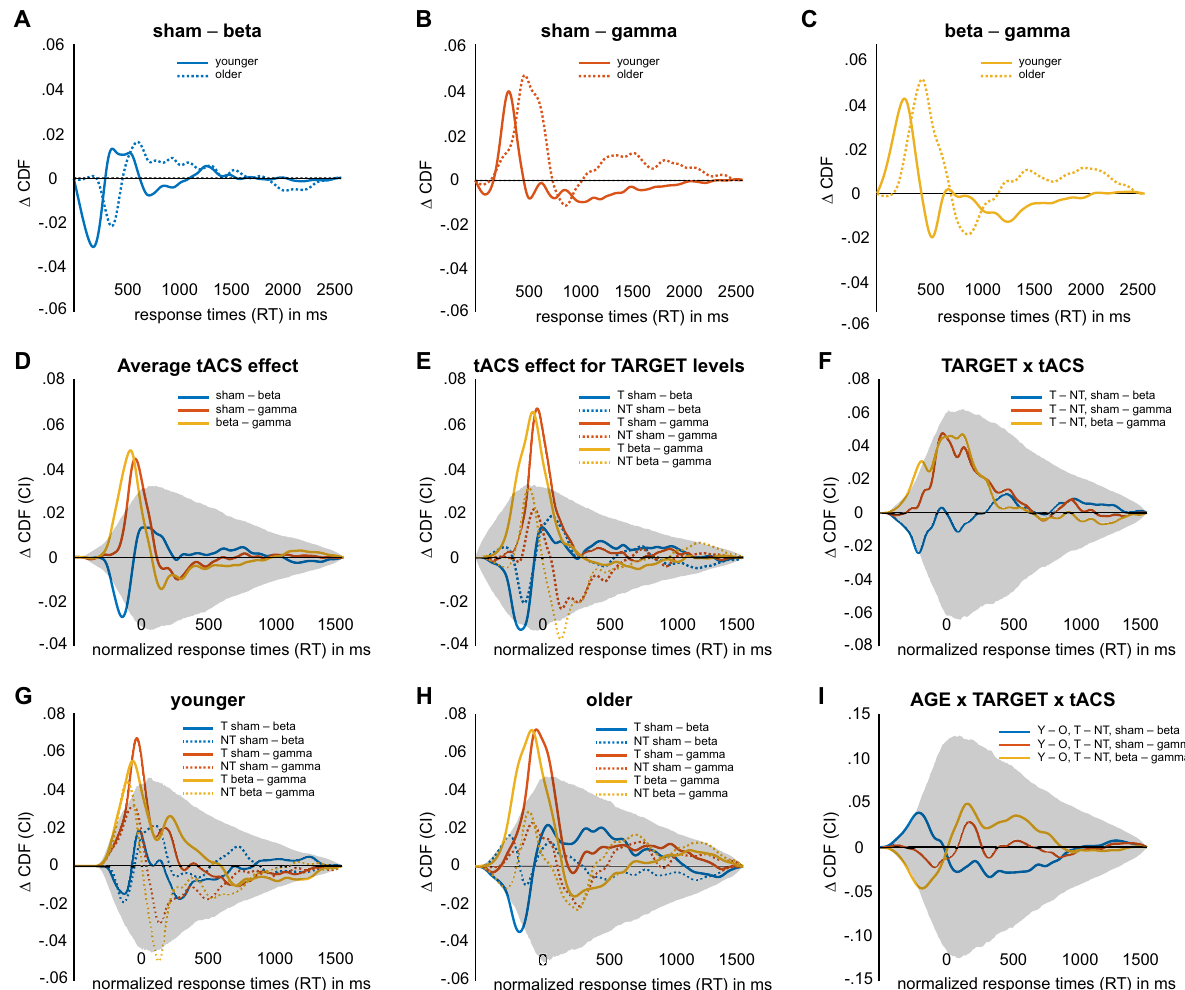
Figure 5. tACS-related differences between cumulative distribution functions (CDFs) of response times (RTs). Grey shaded areas depict confidence intervals corrected for multiple testing. ( A ) Effect of beta tACS (20 Hz) on uncorrected CDFs shown separately for age groups (same data with confidence intervals is depicted in Supplementary Fig. 1). ( B ) Effect of gamma tACS (70 Hz) on uncorrected CDFs shown separately for age groups. ( C ) Difference between beta and gamma tACS on uncorrected CDFs shown separately for age groups. ( D ) Average tACS effect on normalized CDFs. ( E ) tACS effect on normalized CDFs shown for target (solid lines) and non-target (dashed lines) trials. ( F ) Interaction effect between TARGET and tACS. ( G ) The same as in ( B ), but shown only for the younger group. ( H ) The same as in ( B ), but shown only for the older group. ( I ) Interaction between AGE, TARGET and Fig. S2), but not significantly across groups (d ′ ~ MCE: r = − 0.14, p = 0.632; d ′ ~ WME: r = -0.53, p = 0.051; sensory acuity ~ MCE: r = − 0.27, p = 0.356; sensory acuity ~ WME: r = − 0.44, p = 0.119). No other significant correlations with DemTect were observed. A full description of all pairwise correlations between experimental variables in both age groups can be found in Supplementary Fig. S2 and the corresponding text. Third, we investigated potential underlying factors of the observed variables with exploratory factor analysis (EFA) in the group of older adults. Due to the relationship between the two groups of variables (reflected in moderate correlations), we conducted a principal component analysis (PCA) with oblique rotation (Oblimin with Kaiser Normalization) on the residual data of the four variables d ′ , sensory acuity, MCE and WME. Estab- lished tests for the assumptions of this approach were conducted (see “Methods”) 38,39 . We were able to retain two components which jointly explained 84.02% of the variance. Factor loadings after rotation are shown in Table 2, for the pattern matrix as well as the structure matrix. As can also be seen in Fig. 6D, the four variables were resolved in two clearly separable components which showed insignificant, weak correlation ( r = − 0.23, p = 0.395). In the following, we will refer to these two components with “sensory capability” (component 1, with high loadings for d ′ and sensory acuity) and “information integration” (component 2, showing high loadings for MCE and WME), respectively. Finally, we completed a path analysis in the group of older adults based on the factor scores from the two com- ponents and DemTect to investigate how “sensory capability” and “information integration” relate to cognitive